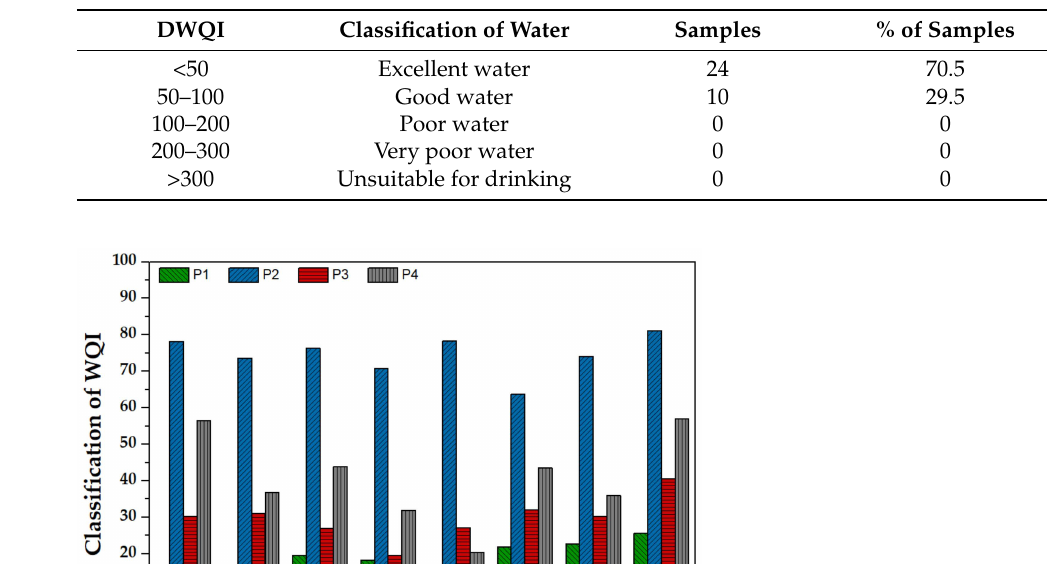
Table 4. Classification of the water quality index and percentage of the values of the Cuernavaca aquifer samples.